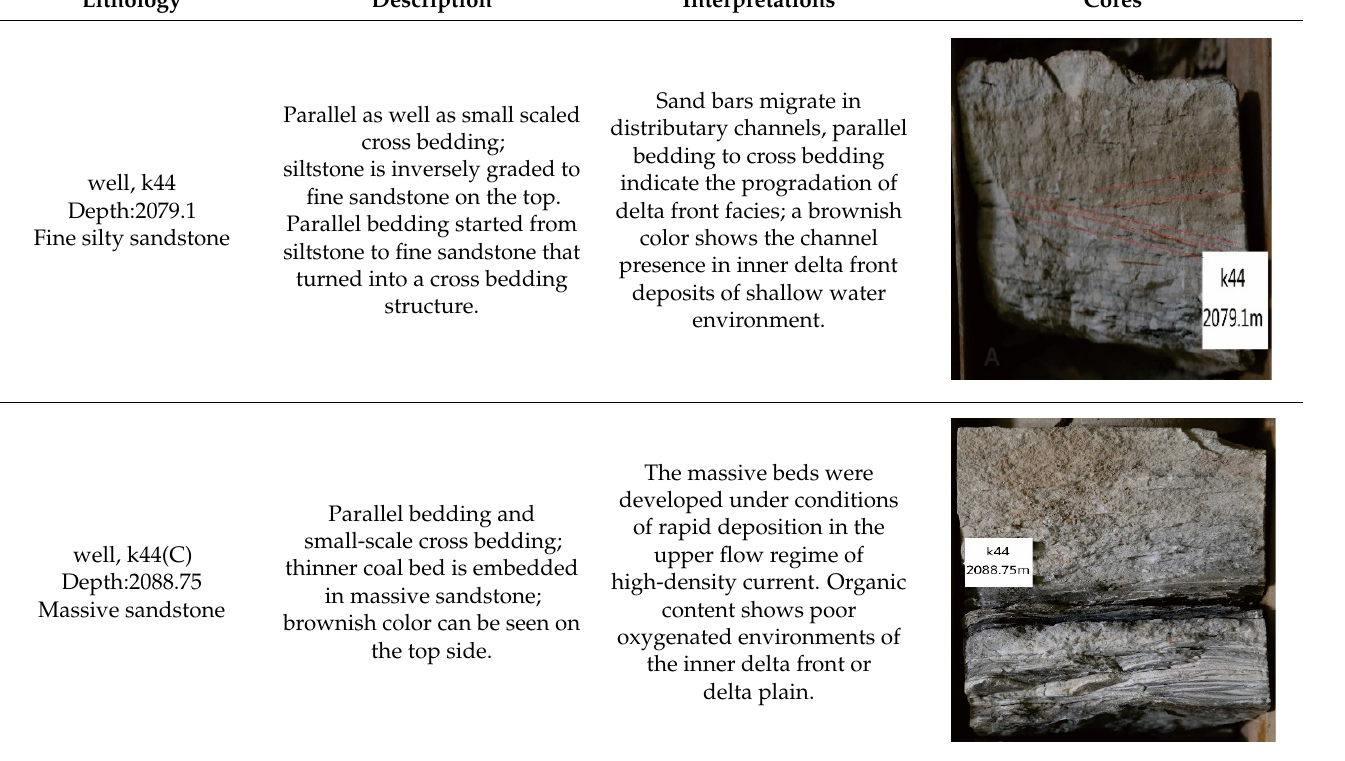
A dark gray or black color Homogenous calcareous shows the sedimentary mudstone (view from the environment of weak top); no obvious Dark gray sedimentary structures are calcareous found. mudstone